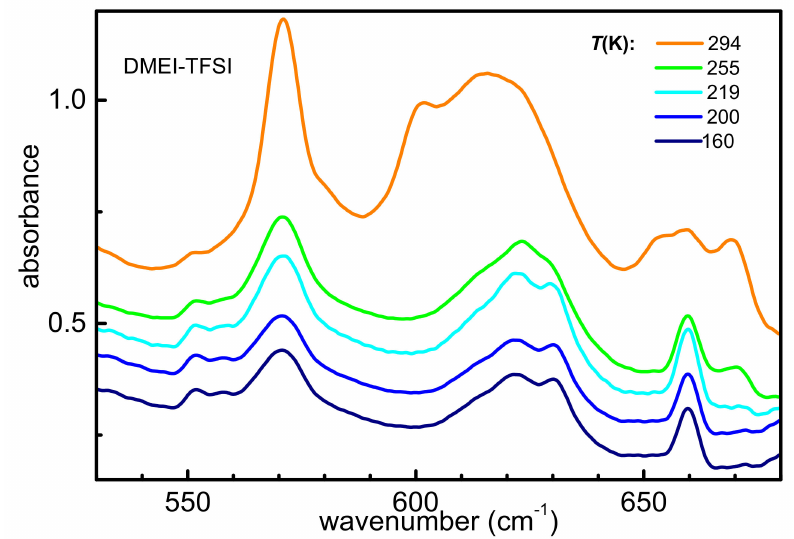
Figure 6. Absorbance of DMEI-TFSI measured on heating between 550 and 700 cm − 1 . The curves are vertically shifted for reasons of